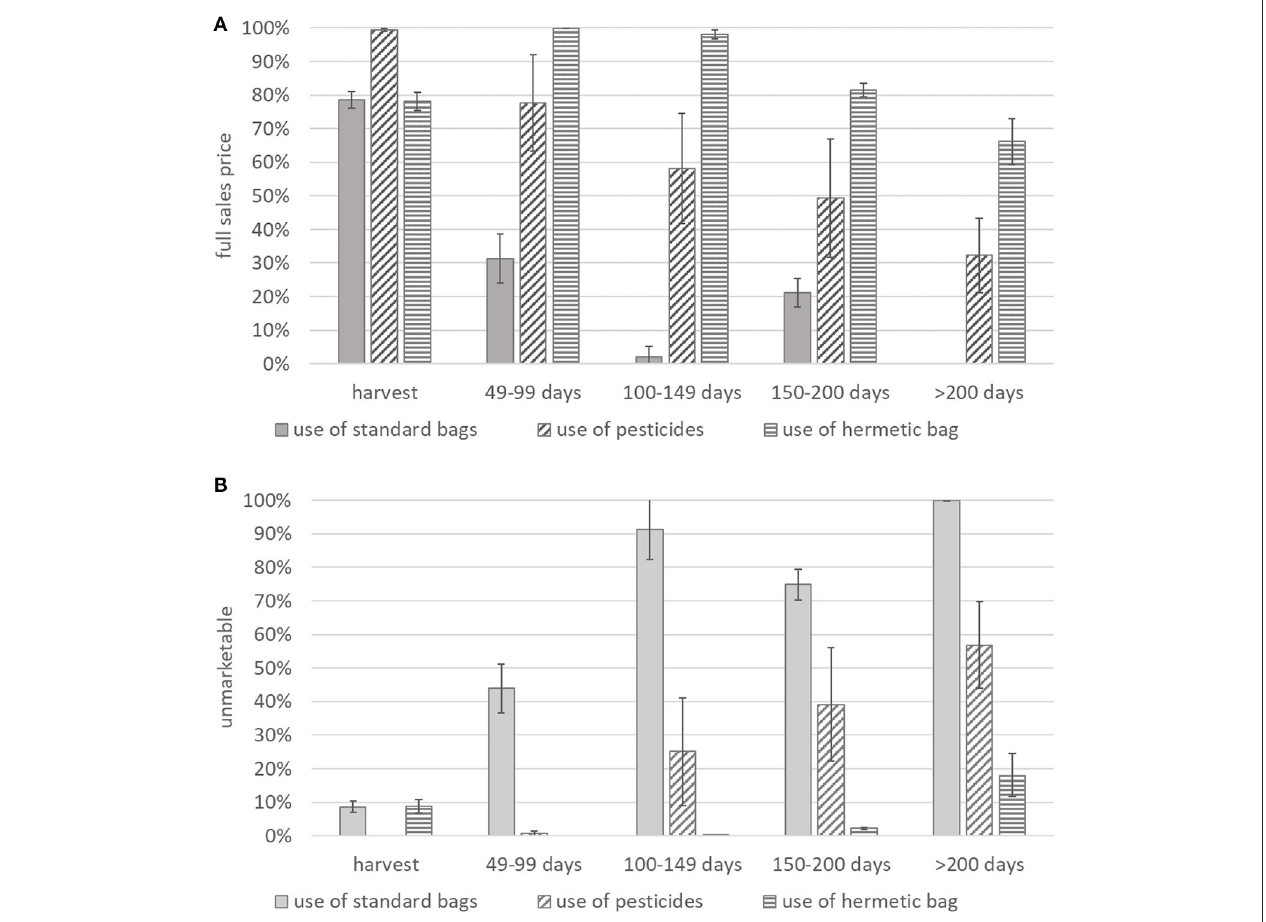
FIGURE 4 | Post-harvest maize quality based on the amount of damaged grain by insects during different storage scenarios. Based on field data from Baoua et al. (2014), Ng’ang’a et al. (2016b), Mlambo et al. (2017). (A) % of full sales price when damaged grain level is < 10%. (B) % Unmarketable for human consumption, > 20% damaged grain. Error bars represent 95% confidence